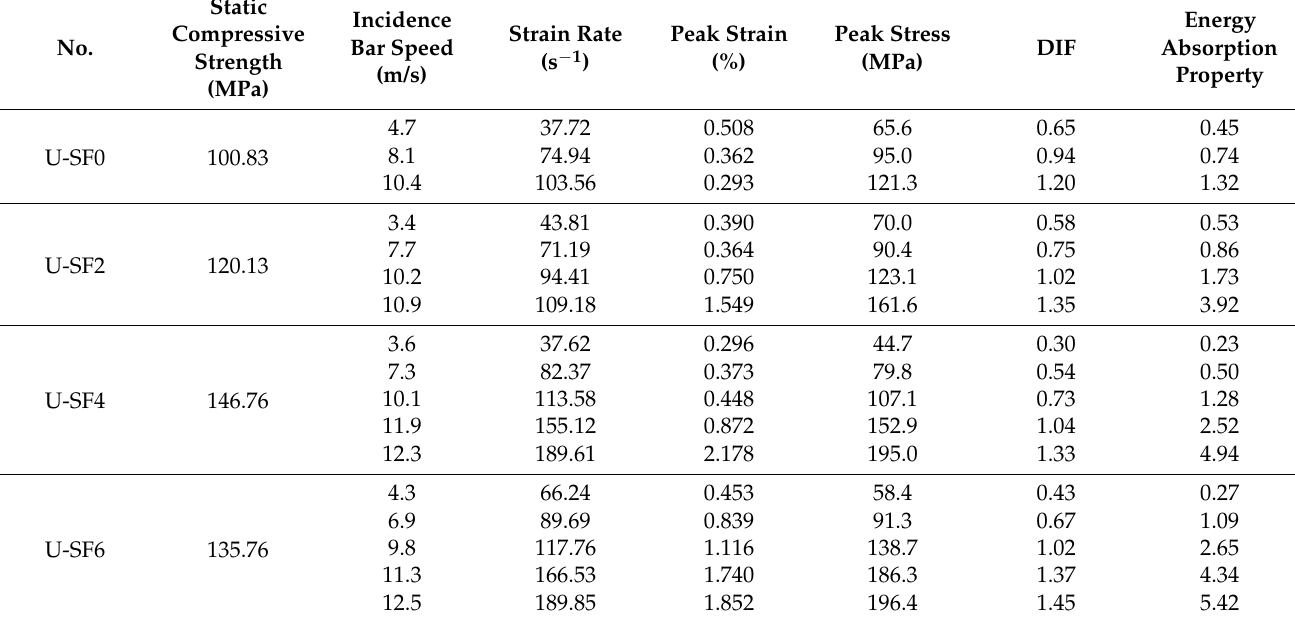
Table 3. Influence of non-oriented fiber content on impact compression performance.